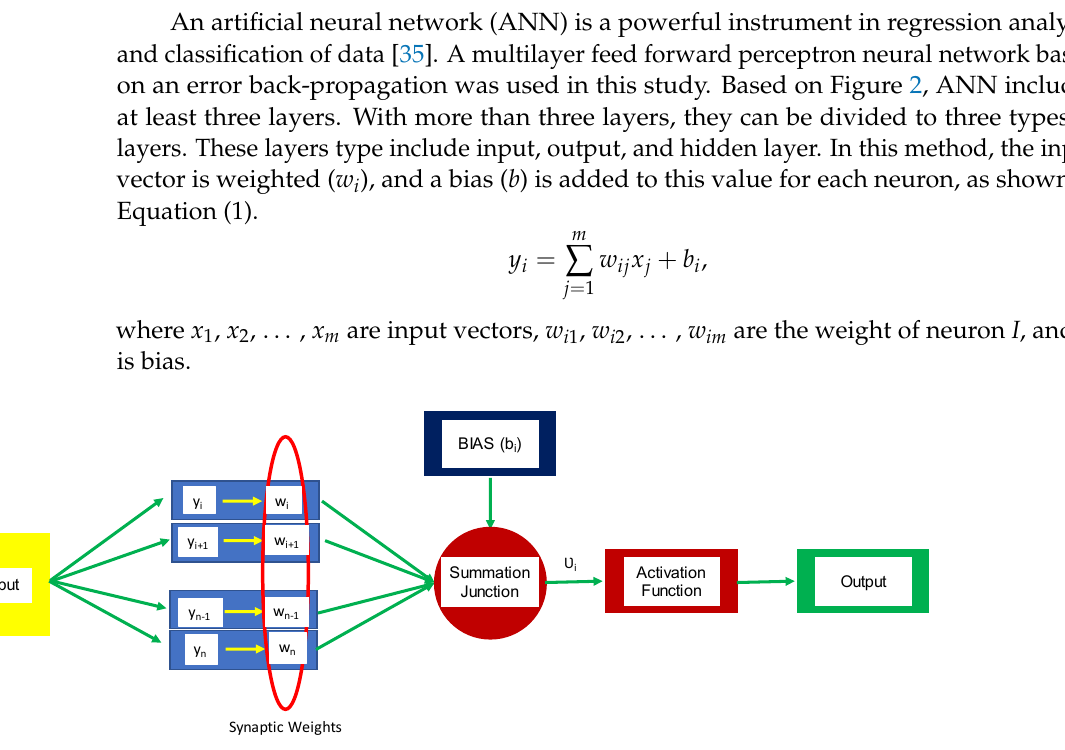
Figure 2. Nonlinear model of a neuron.